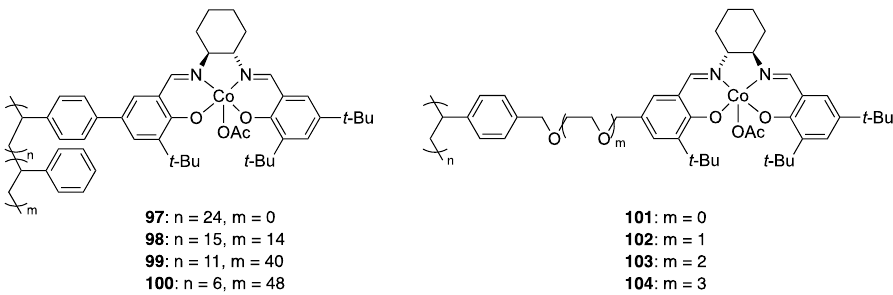
Figure 38. Homo- and copolymerized Co–salen complexes 97 – 100 and homopolymerized Co–salen complexes 101 – 104 .